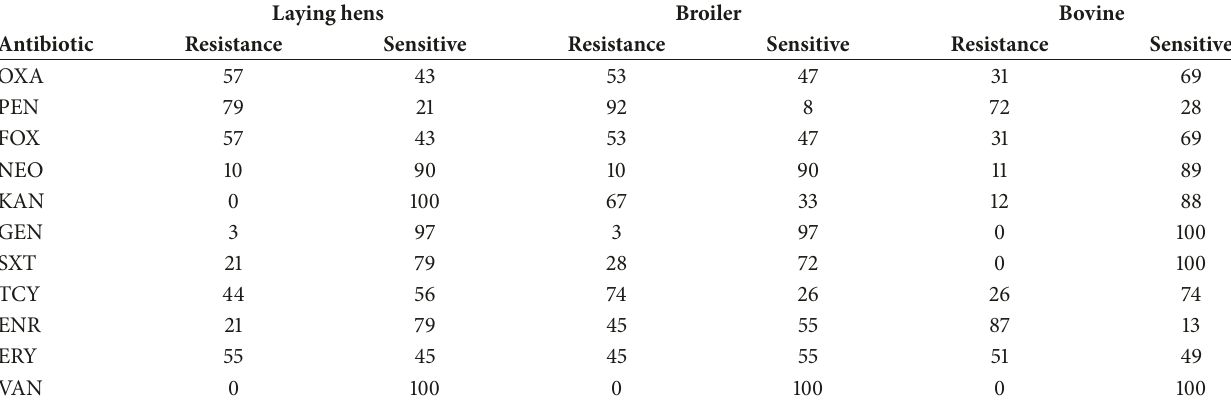
Table 3: Percentage of antibiotic resistance and sensitivity in S. aureus